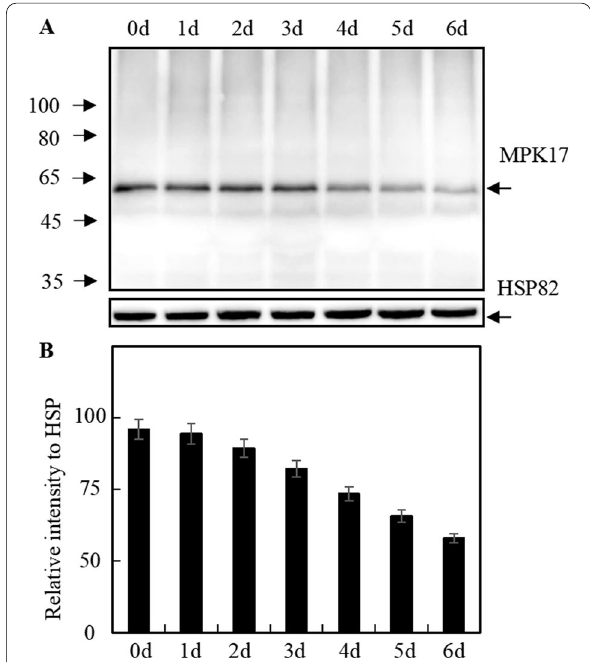
Fig. 1 Expression of MPK17 in rice leaves at different time points following inoculation with Xoo . A Representative Western blot. B Expression level relative to HSP82. MPK17: anti- MPK17 antibody-detected band; HSP82: anti- HSP82 antibody detected-band used as loading control. 4021: transgenic TP309 lines harboring the Xa21 gene. Protein signals generated by WB were detected by Mini Chemiluminescent Imager and Sage Capture software. Lane 1D software was used to extract signals of WB. Relative intensity to HSP82 were calculated according to the intensity of MPK17 divided by the intensity of HSP82 signal. Mean was calculated for three repeats. Error bars are standard deviation